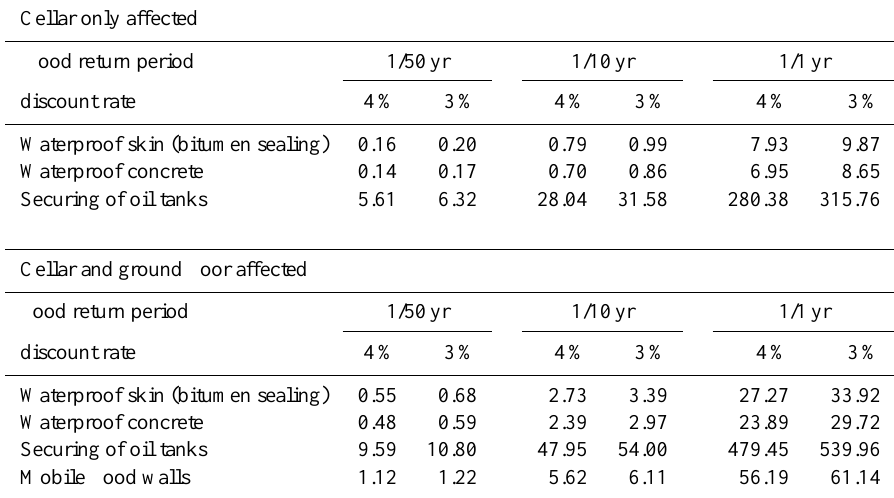
Table. Benefit-cost ratios for different precautionary building measures under different flood scenarios, calculated with different discount